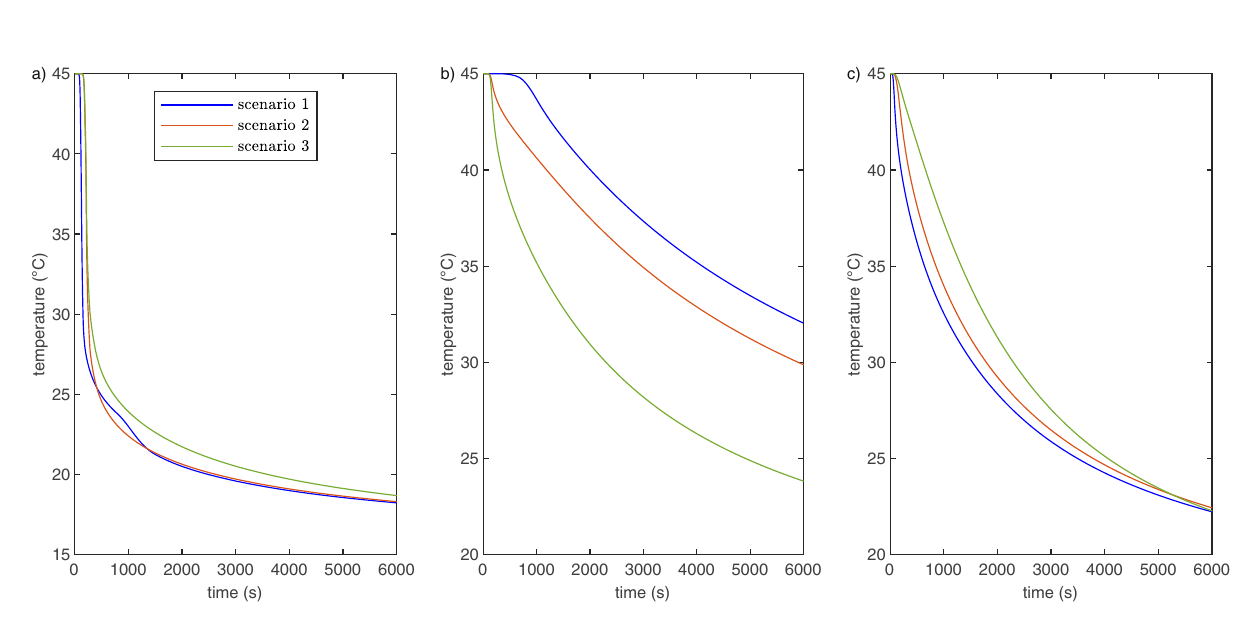
Fig. 4 | Scenario testing. Simulated water temperatures at out fl ow ( a ) as well as rock temperatures at fractures 3 ( b ) and 6 ( c ) for a water in fl ow of 15°C in the bench-scale setup with a rock temperature of 45°C. Scenarios: (1) mass fl ow